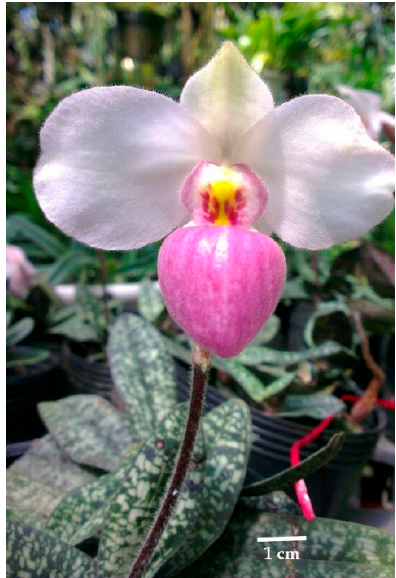
Figure 5. The flower of endemic species Paphiopedilum delenatii.